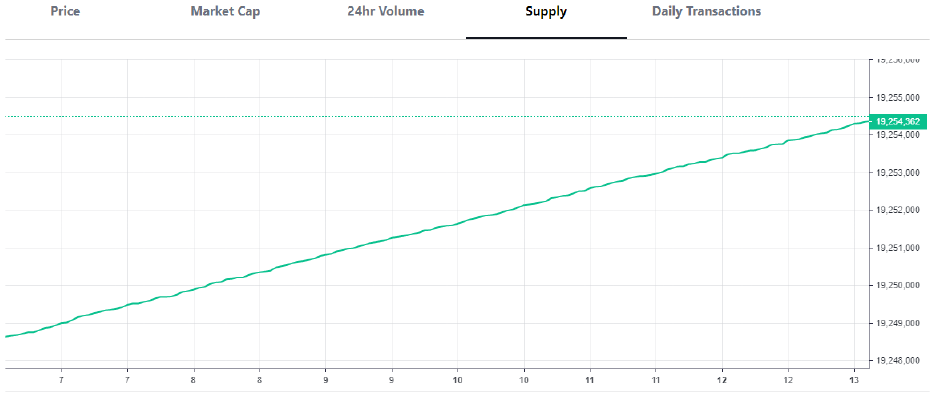
Figure 7. BCH money supply in June 2021 was at its peak, i.e., BTC 18.8 M, and its value on December 2022 was 19,254,487 [10].